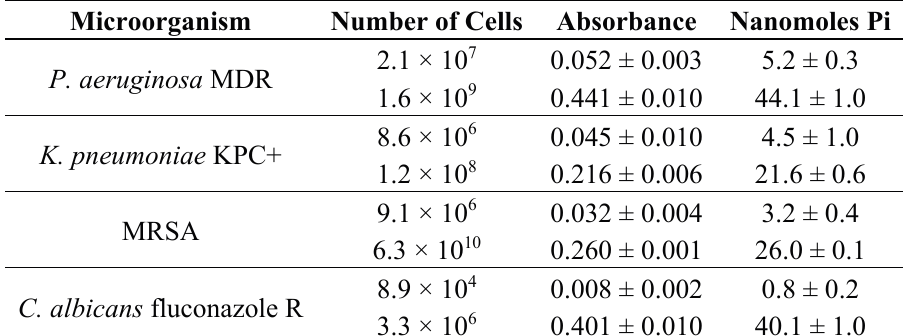
Table 3. Determination of total inorganic phosphorus (Pi) for the MDR microorganisms at two different cell number